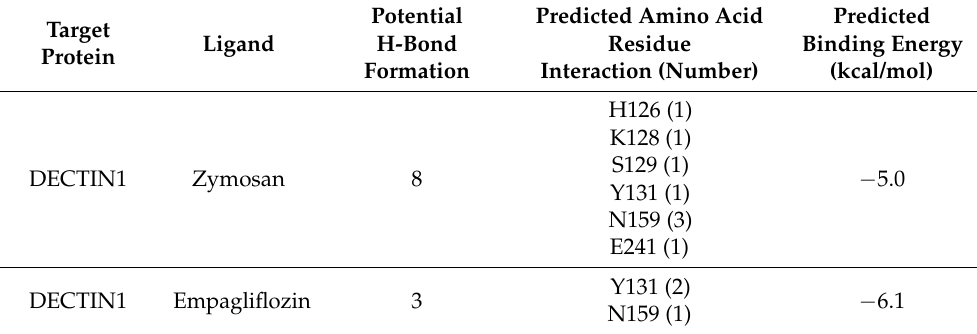
Table 2. Predicted protein–ligand interactions for DECTIN1-Zymosan and DECTIN1-Empagliflozin with binding energies from docking